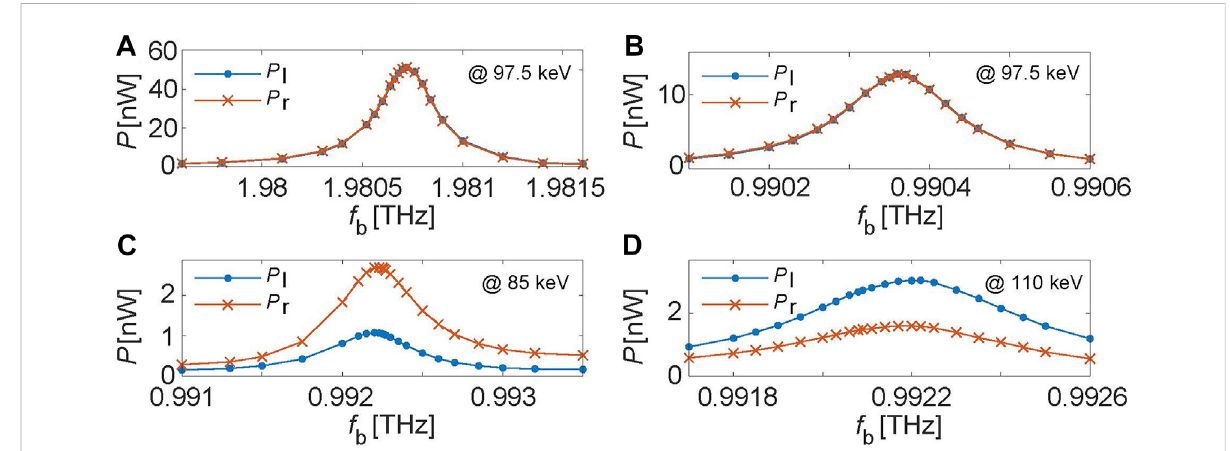
FIGURE 5 Simulation results for the effect of repetition frequency and electron energy on the leftward output power P l and rightward output power P r . Withelectronenergybeing97.5keV,therepetitionfrequencyistunedaround1.98 THzin (A) and0.99 THzin (B) .Withtherepetitionfrequencybeing tuned around 0.99 THz, the electron energy is 85 keV in (C) and 110 keV in (D)